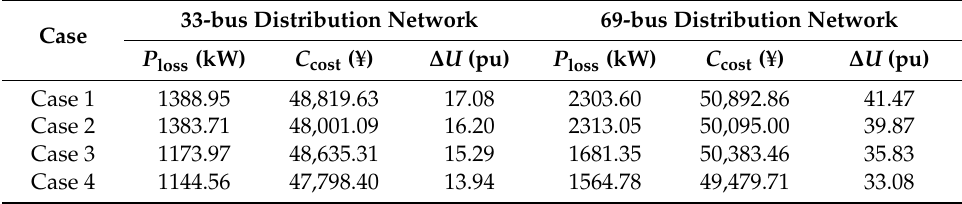
Table 5. Optimization results of the two distribution networks under different cases.